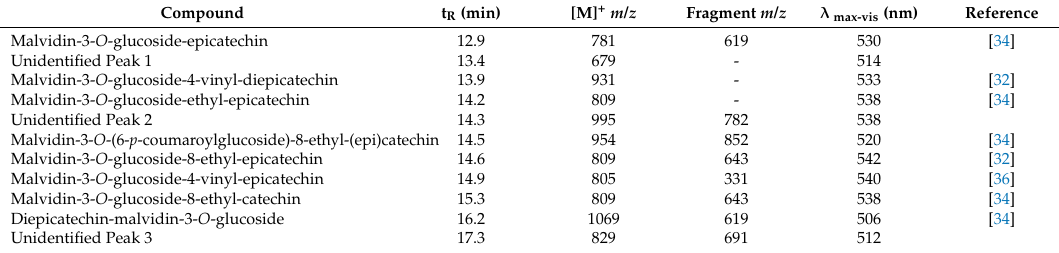
Table 4. Pigments identified with HPLC-DAD-ESI/MS with DAD signal at 525nm. Compound t R (min) [M] + m / z λ max-vis